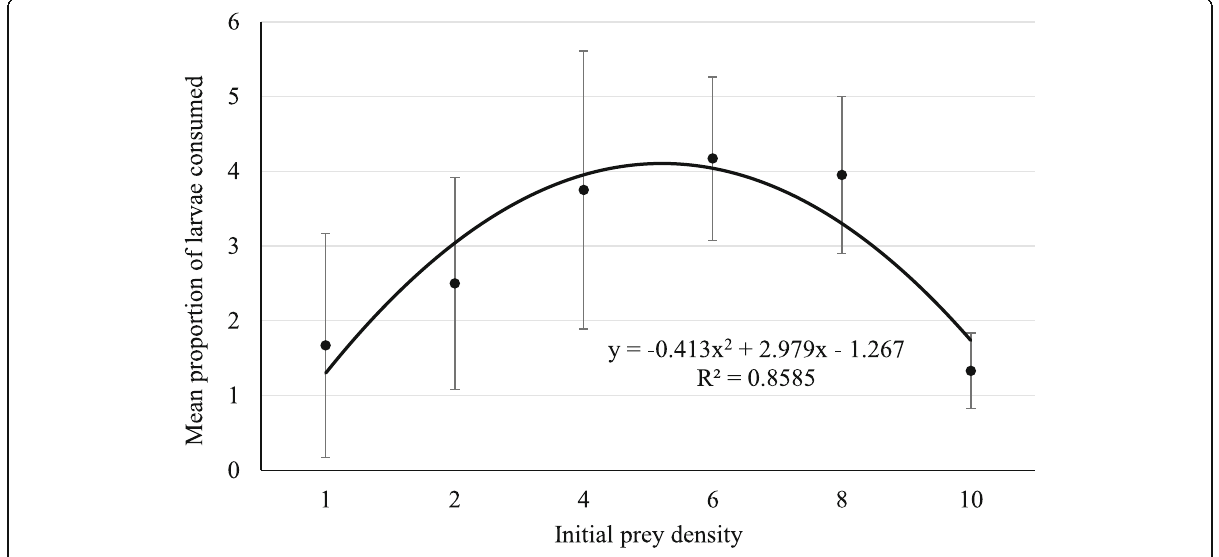
Fig. 1 Mean proportion of P. truncatus larvae consumed by A. biannulipes at six different densities